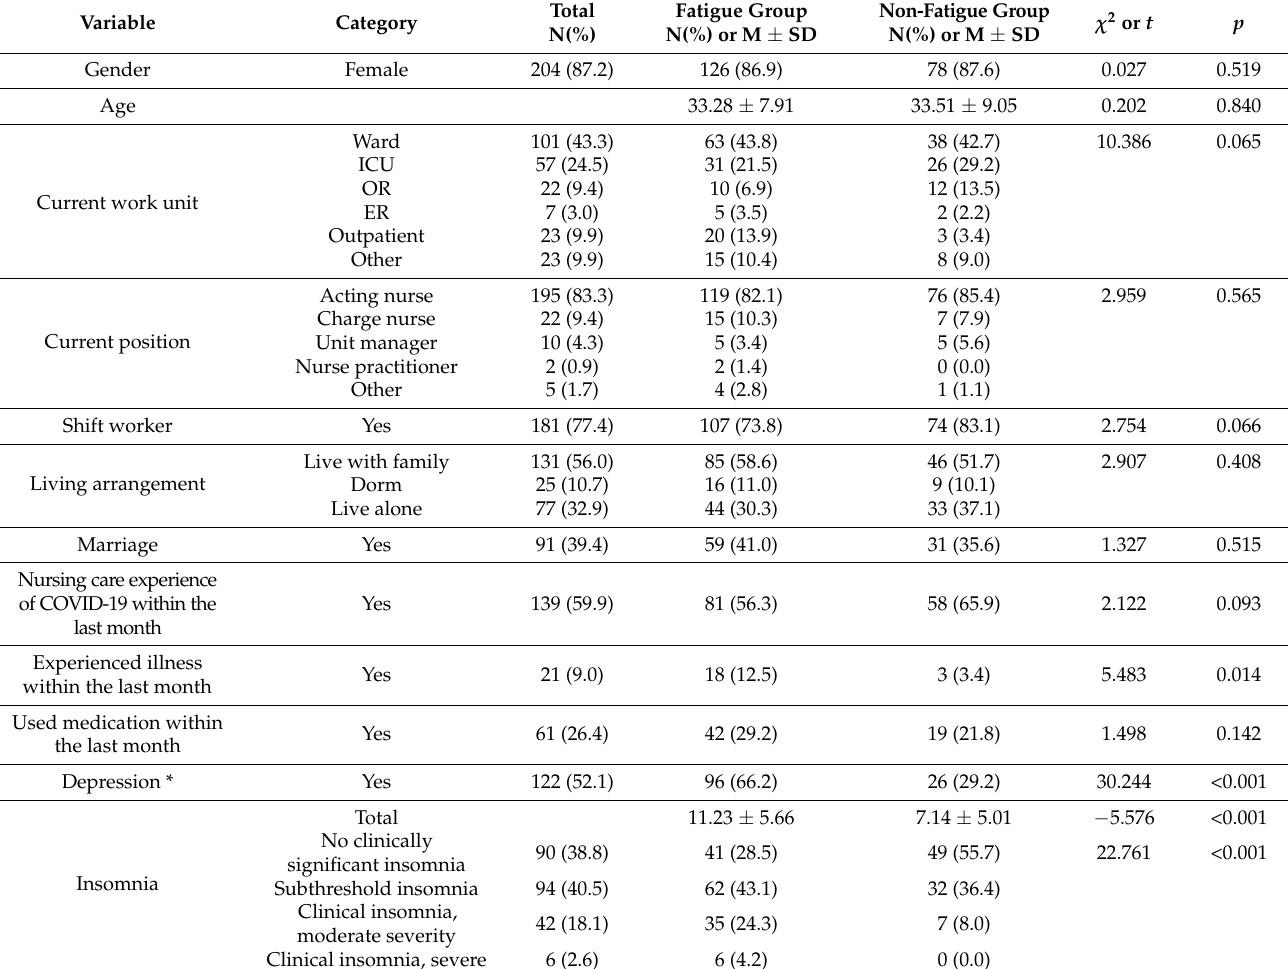
Table 2. Participants’ general characteristics, depression, insomnia, daytime sleepiness, and occupa- tional stress (N =